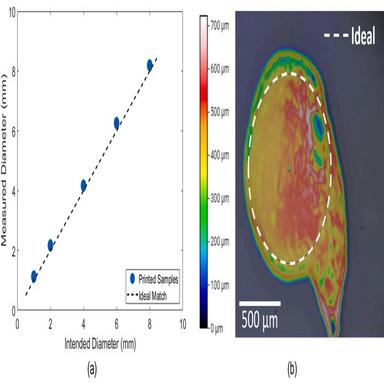
(a) The measured diameters of printed cylinders plotted against the intended diameter set by the Gcode along with (b) an optical profilometer image of smallest cylinder attempted (D = h = 1 mm).